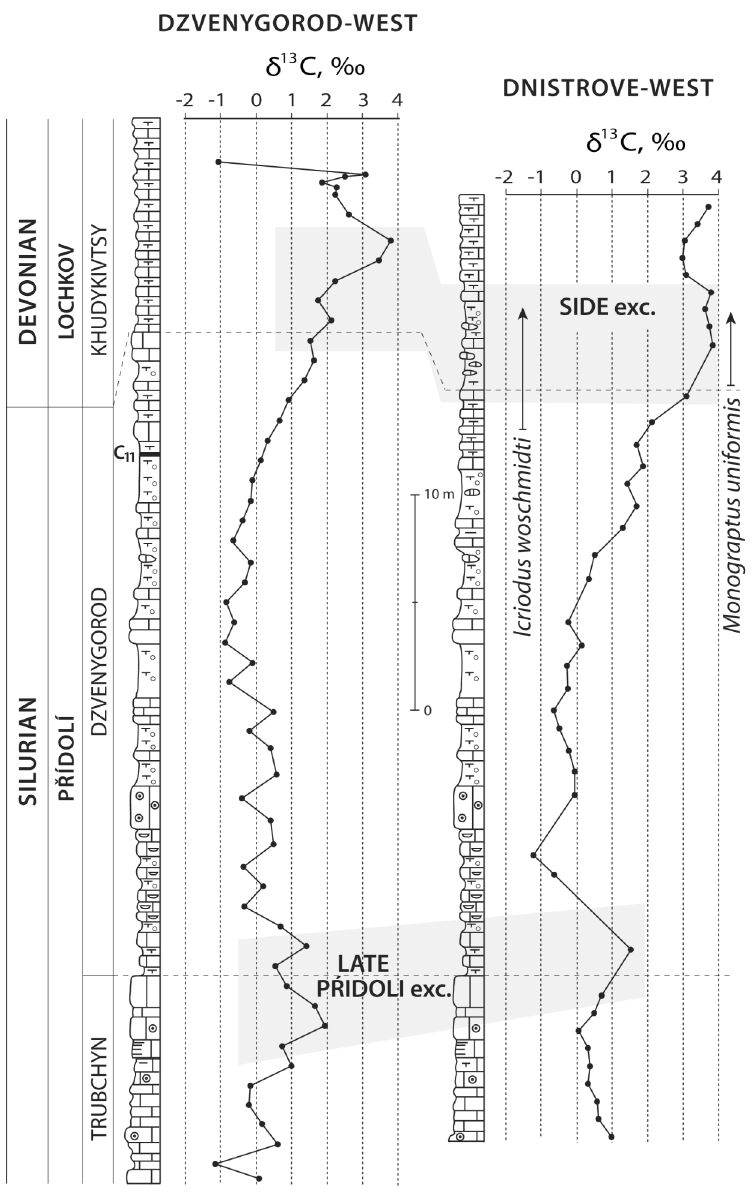
Fig. 5. Upper P ř (cid:237)dol(cid:237) δ 13 C curves from the Dniester area. Log and lithostratigraphy from Tsegelnyuk et al. (1983). For legend see Figs 2 and